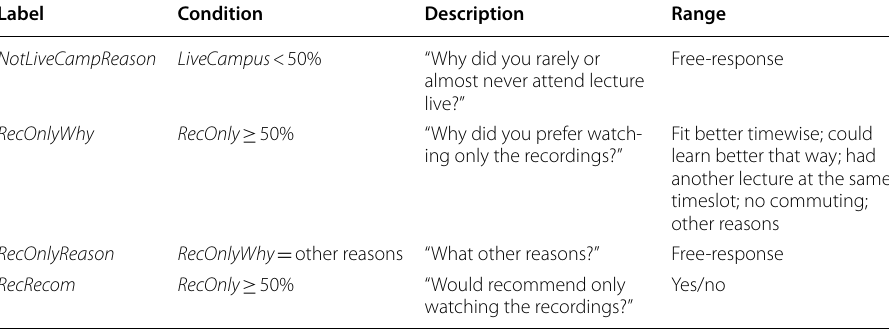
Table 2 The labels, conditions, descriptions, and ranges of attributes considered in this study that were only surveyed depending on other attributes